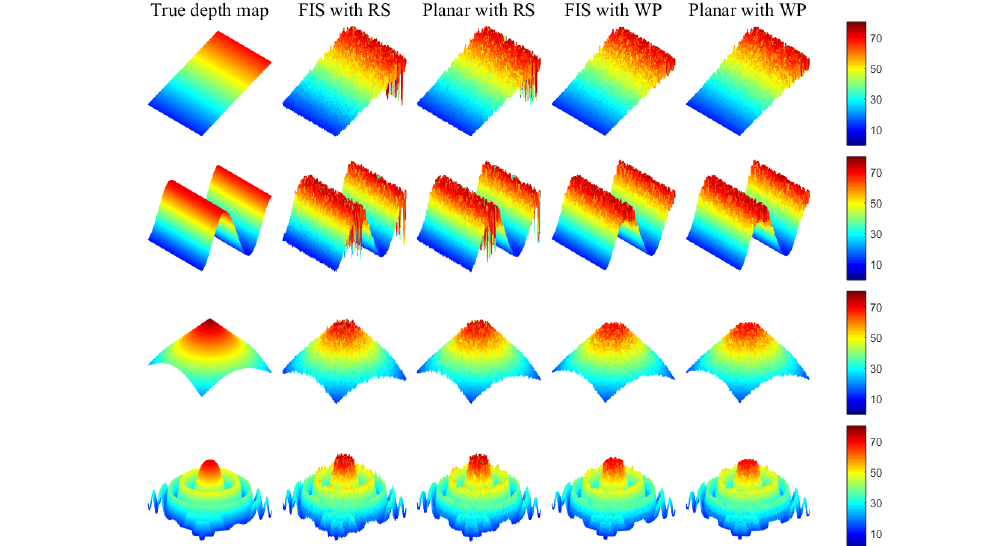
Figure 9. Restored 3D depth map for various SFF methods using various synthetic objects, first row: plane object, second row: sinusoidal object, third row: cone object, and fourth row: wave object. In addition, first column: True depth map, second column: NN.FIS with RS, third column: NN.Planar with RS, fourth column: NN.FIS with WP, and fifth column: NN.Planar with WP.